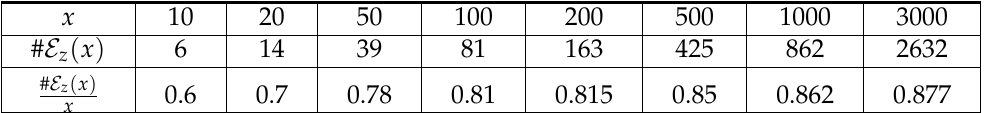
Table 3. Quantity and proportion of arguments for which z ( n ) is